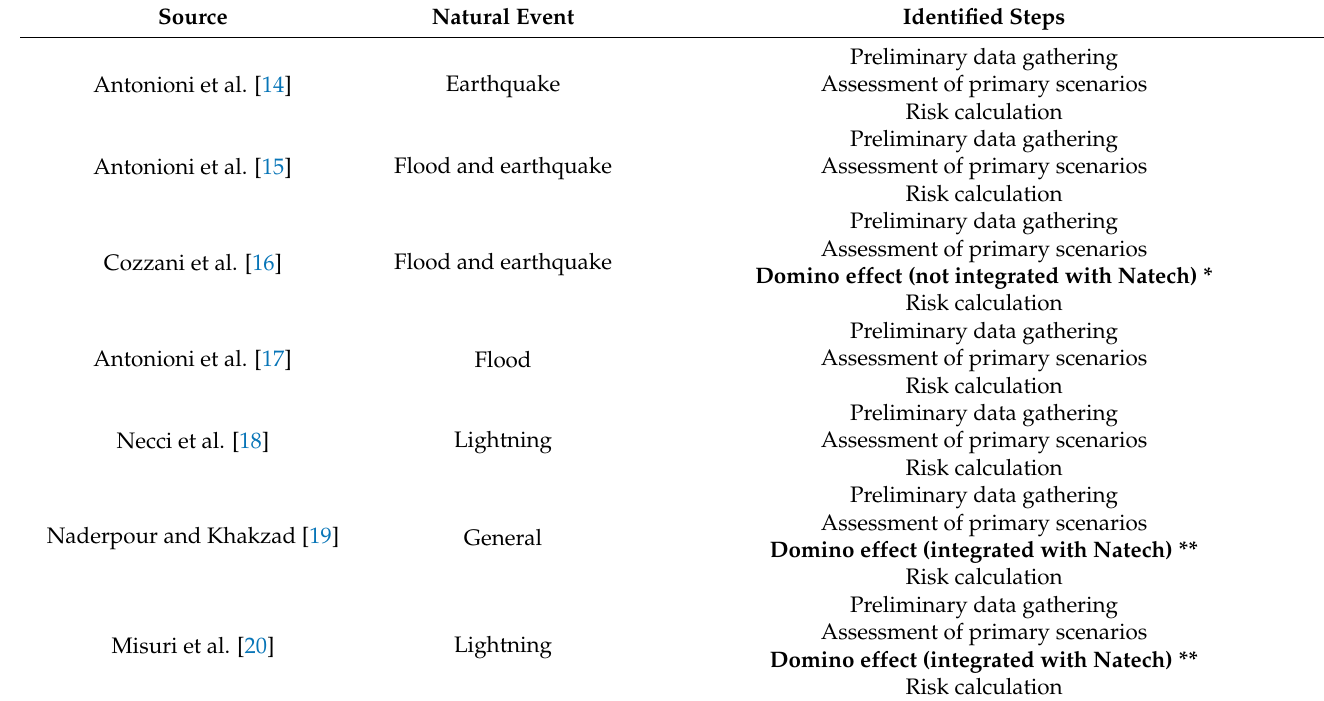
Table 2. Natech QRAs